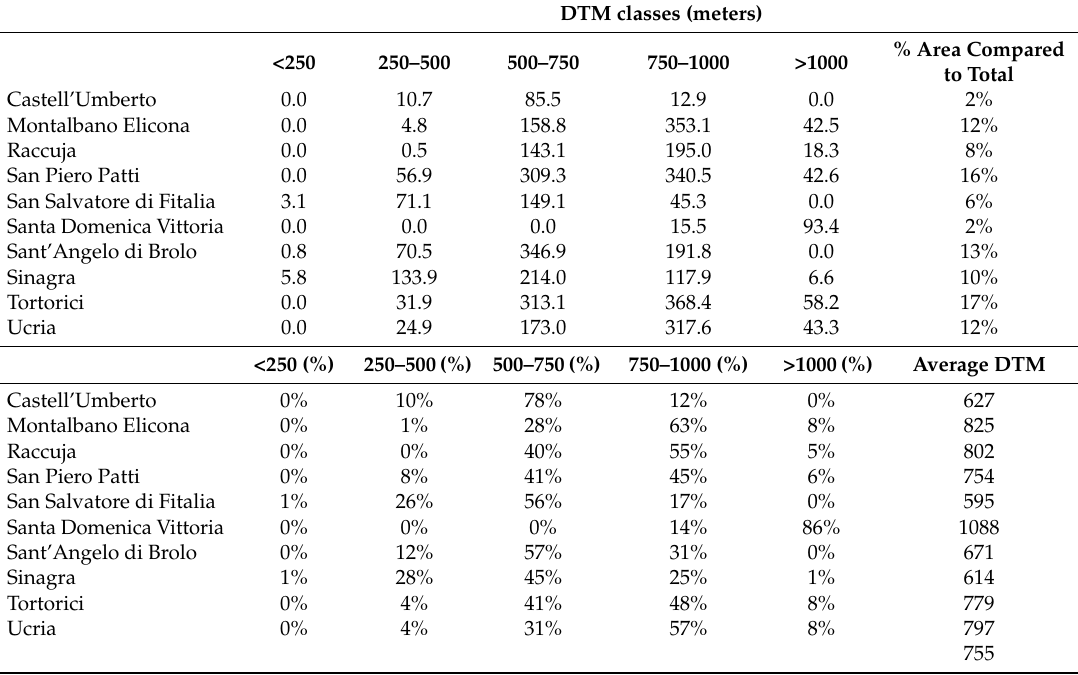
Table 2. Surface area (hectares) (top) and percentage (bottom) of hazelnuts for each municipality depending on DTM classes